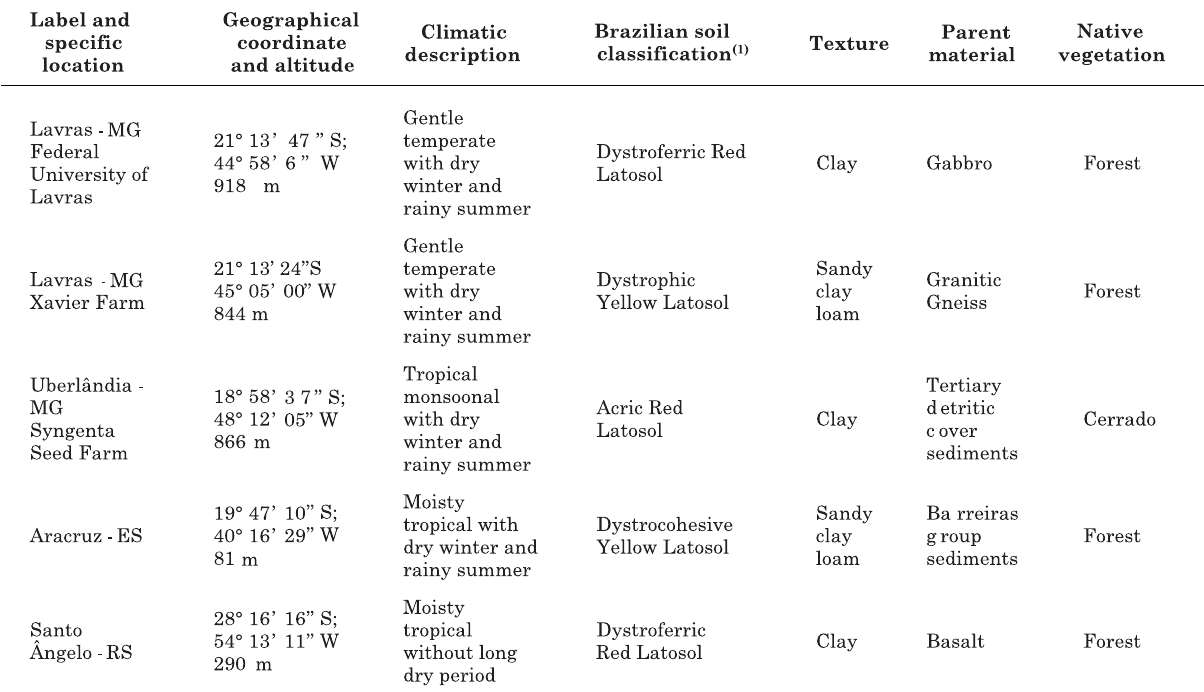
Table 1. Sampling sites and soil